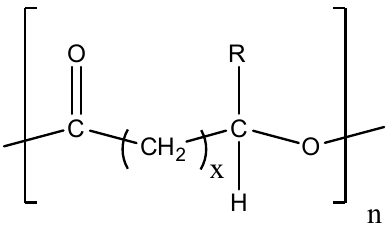
Figure 3. Polyhydroxyalkanoate monomeric unit.